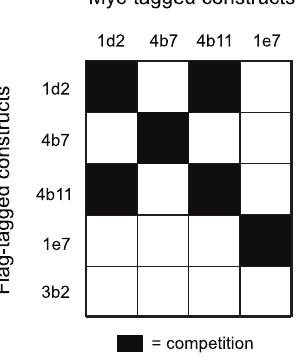
Figure 3. Epitope mapping of VHHs. Myc-tagged VHHs were incubated with increasing amounts of flag-tagged VHHs in an hpIgR coated well for 2 h at room temperature. Myc tag presence was subsequently quantified and competition therewith assessed. Compe- tition is depicted in a chequer board diagram were black indicates competing VHHs (n=2). See Figure S2 for raw data.